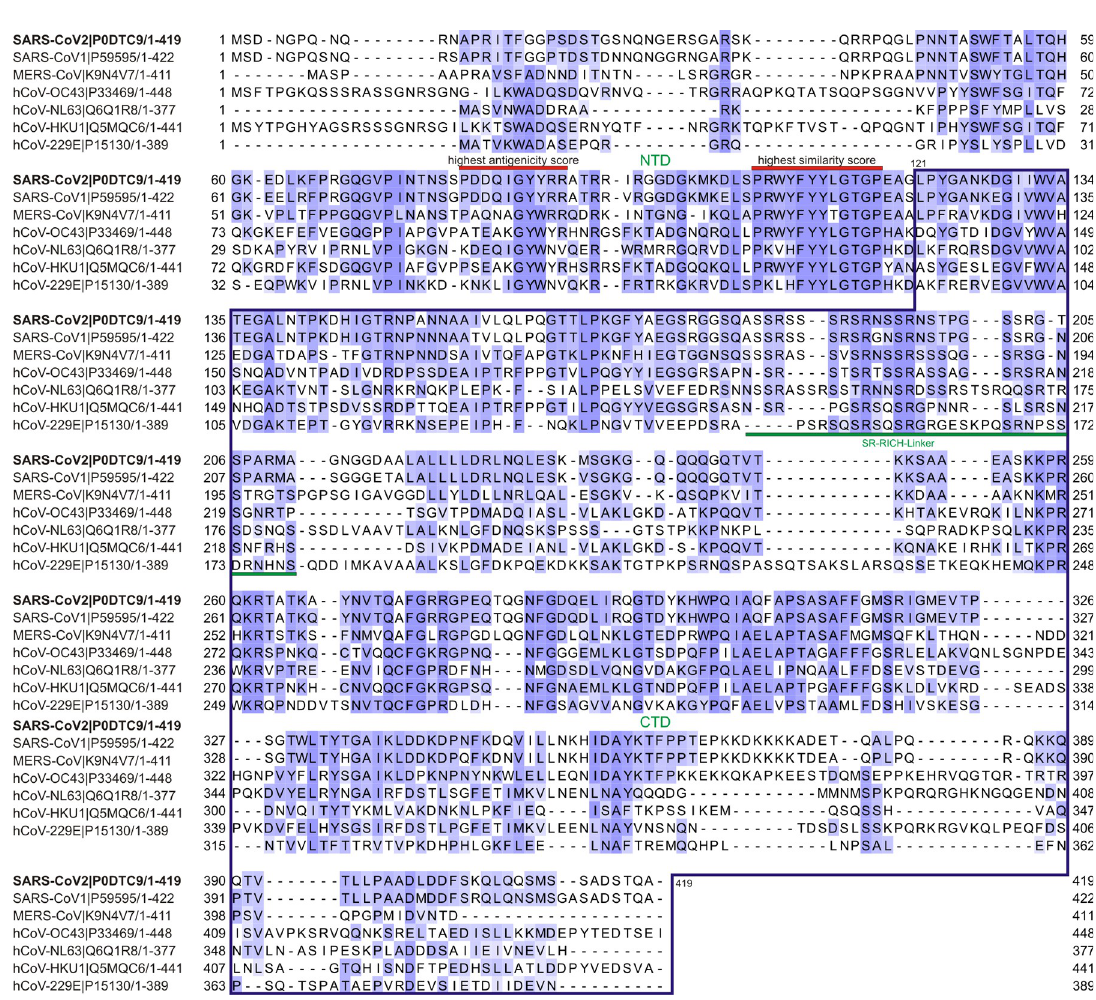
Fig 1. Amino acid sequence conservation of predicted linear peptide epitope sequences from human coronavirus nucleocapsid proteins (N). JalView Clustal Omega multiple sequence alignment of viral nucleoproteins are shown across all five known human β - coronaviruses: SARS-CoV-2 (P0DTC9); SARS-CoV (P59595); hCoV-HKU1 (Q5MQC6); hCoV-OC43 (P33469); MERS-CoV (K9N4V7) and two known human α -coronaviruses: hCoV-229E (P15130) and hCoV-NL63 (Q6Q1R8). Each row in the depicted alignments corresponds to the protein sequence from the indicated coronavirus identified by UniprotKB accession numbers with the starting position of the viral amino acid sequence shown at left and position coordinates of the overall blue shading indicates the extent of sequence similarity by BLOSUM62 score, with the darkest blue shading indicating a 100% match for that amino acid across all sequences. The red-highlighted sequences correspond to highly conserved and highest antigenicity predicted epitope peptides scores. NTD: N-terminal domain or RNA binding domain and the CTD: C-terminal domain or dimerization domain are separated by a SR-Rich-Linker delimitated by a green bar. The blue outline box delineates the corresponding coding sequence cloned to express the fragment of nucleocapsid protein used to detect specific antibodies against SARS-CoV-2 N122-419.